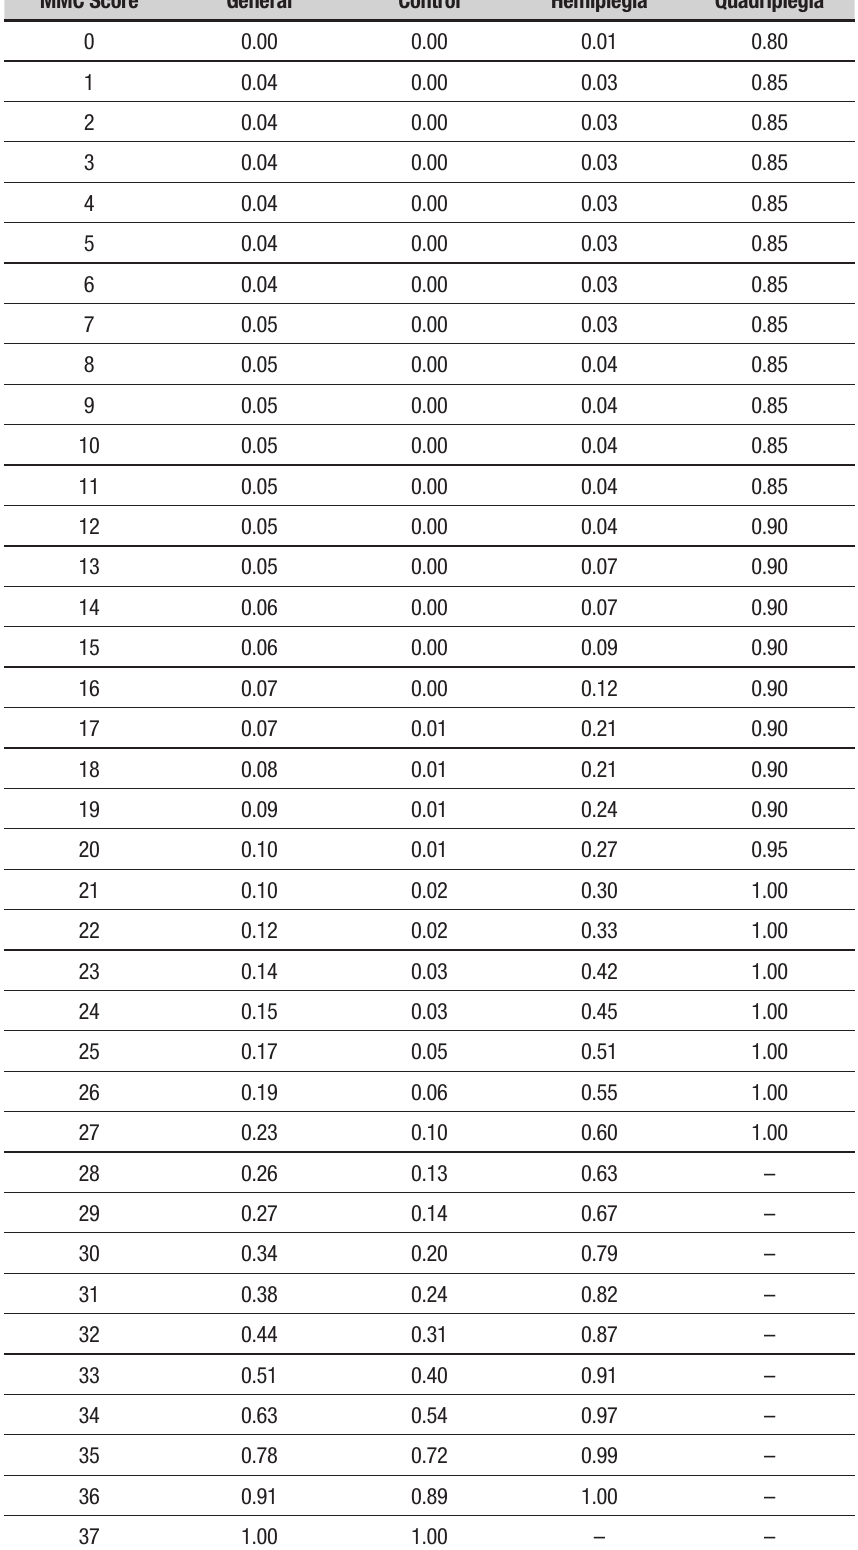
Table 3. Cumulative percentiles and cut–off scores for the three groups on MMC. MMC